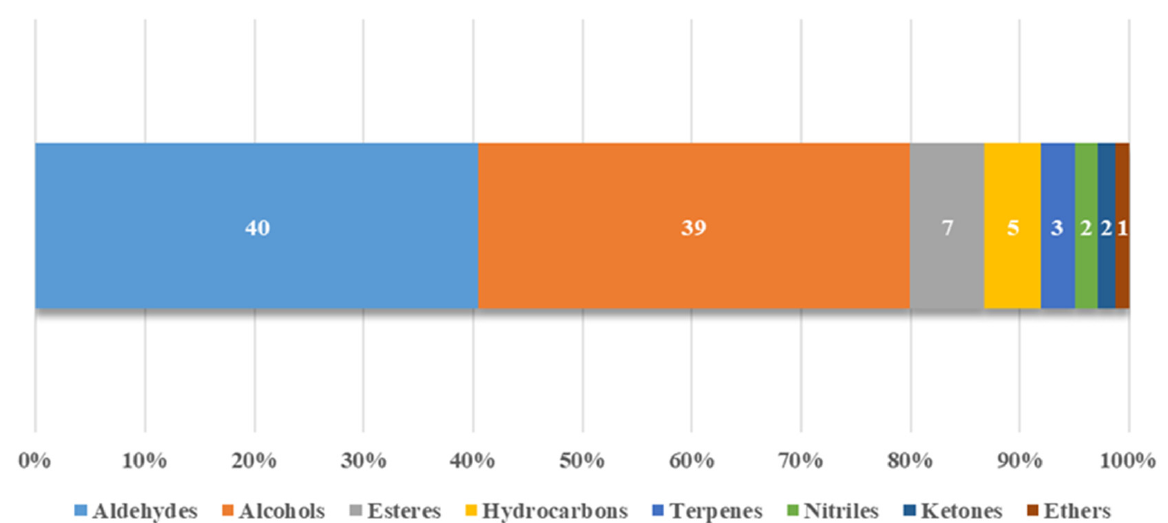
Figure 1. Volatile profile (%) of extra virgin olive oils considering the main classes of the compounds determined.